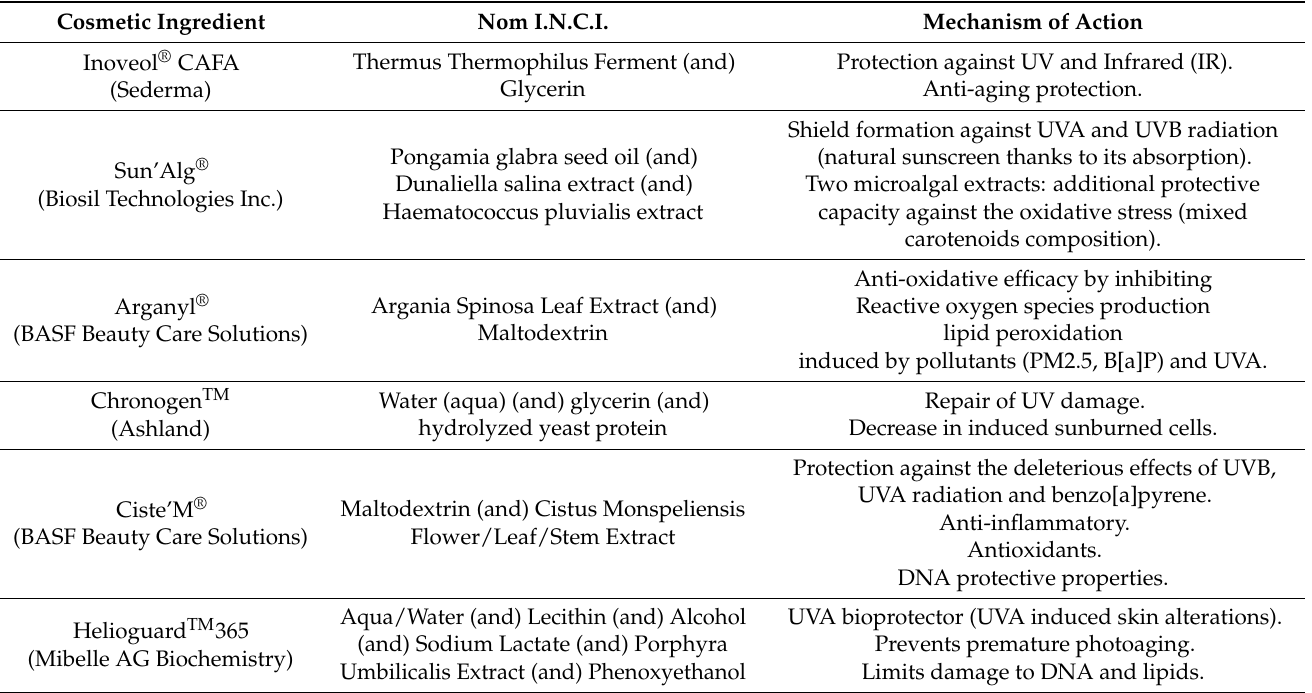
Table 1. Non-exhaustive list of marketed cosmetic ingredients related to photoprotection according to their mechanisms of action. I.N.C.I.: International Nomenclature of Cosmetic